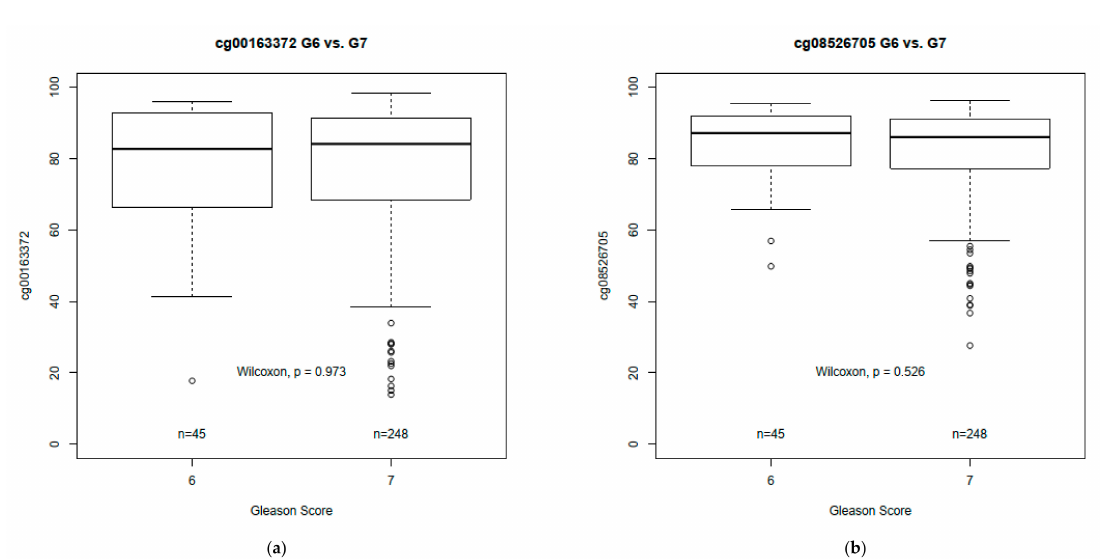
Figure A1. Box plots displaying the median % DNA methylation and interquartile range (25th: 75th percentiles) by Gleason score (GS 6 vs. GS 7) for the two MYC exon 3 CpG sites evaluated in The Cancer Genome Atlas (TCGA) data, n = 293 prostate tumor samples: ( a ) cg00163372 and ( b )